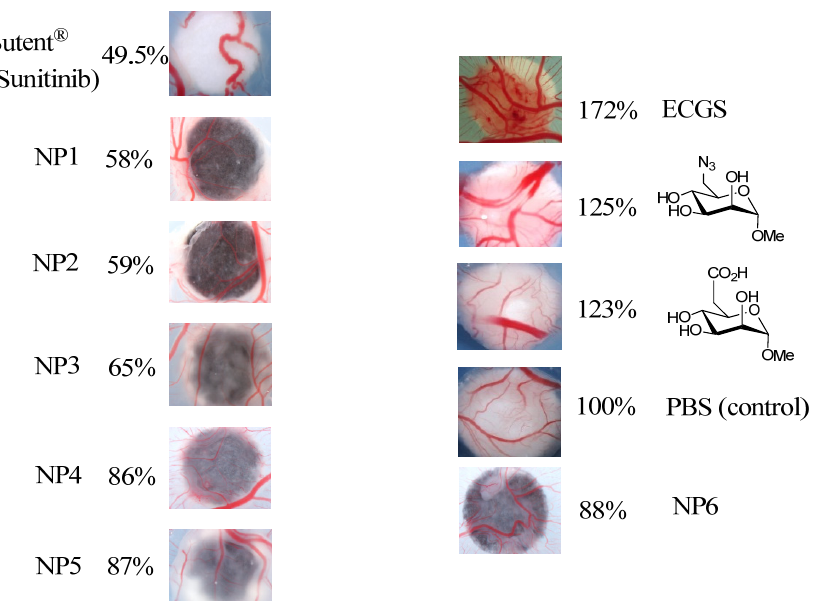
Figure 1. CAM assays using gold nanoparticles functionalized with mannose-6-phosphate analogues compared to angiogenic inhibitor Sutent ® , angiogenic activator Endothelial Cell Growth Supplement (ECGS) and Phosphate Buffer Saline (PBS) as